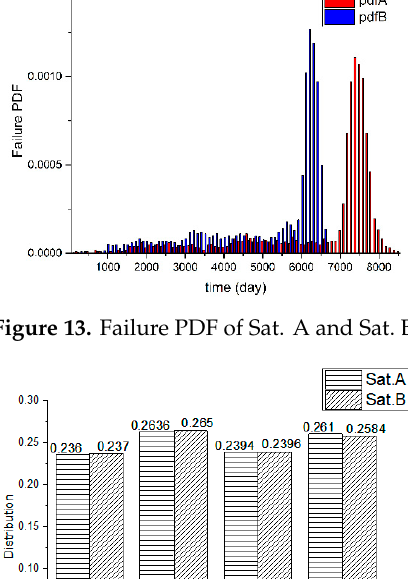
Figure 12. Probability distribution of the predicted life.